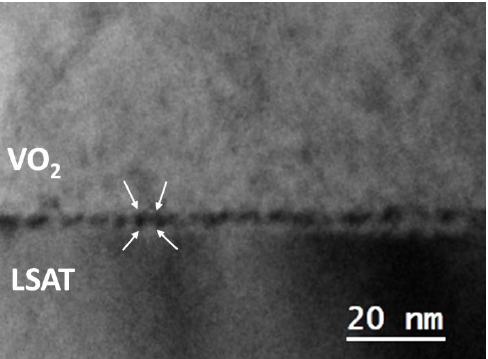
Figure 3. Cross-sectional image of the VO 2 /LSAT interfacial area, viewed by the [001] LSAT zone axis.